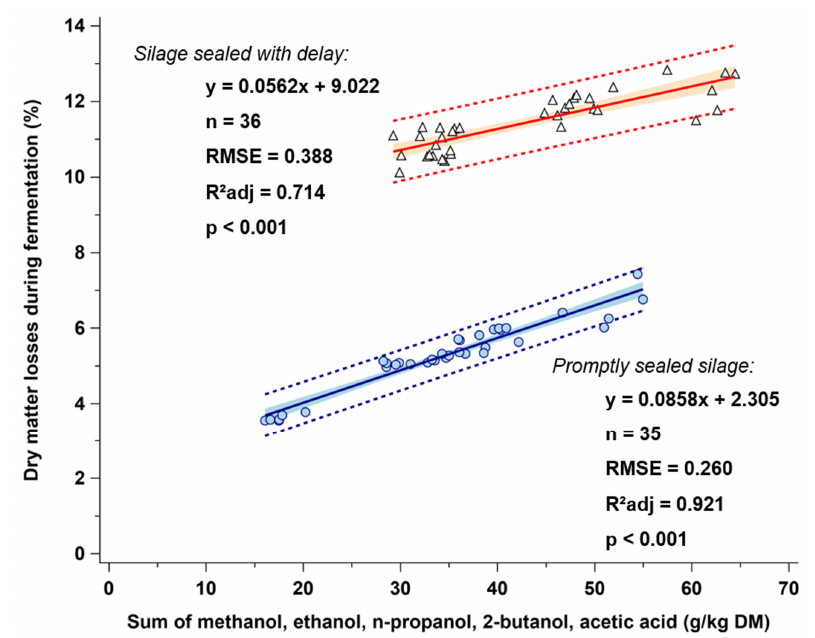
Figure 6. Dry matter losses as a function of the total concentration of methanol, ethanol, n-propanol, 2-butanol and acetic acid in in maize silages sealed promptly or with a delay.